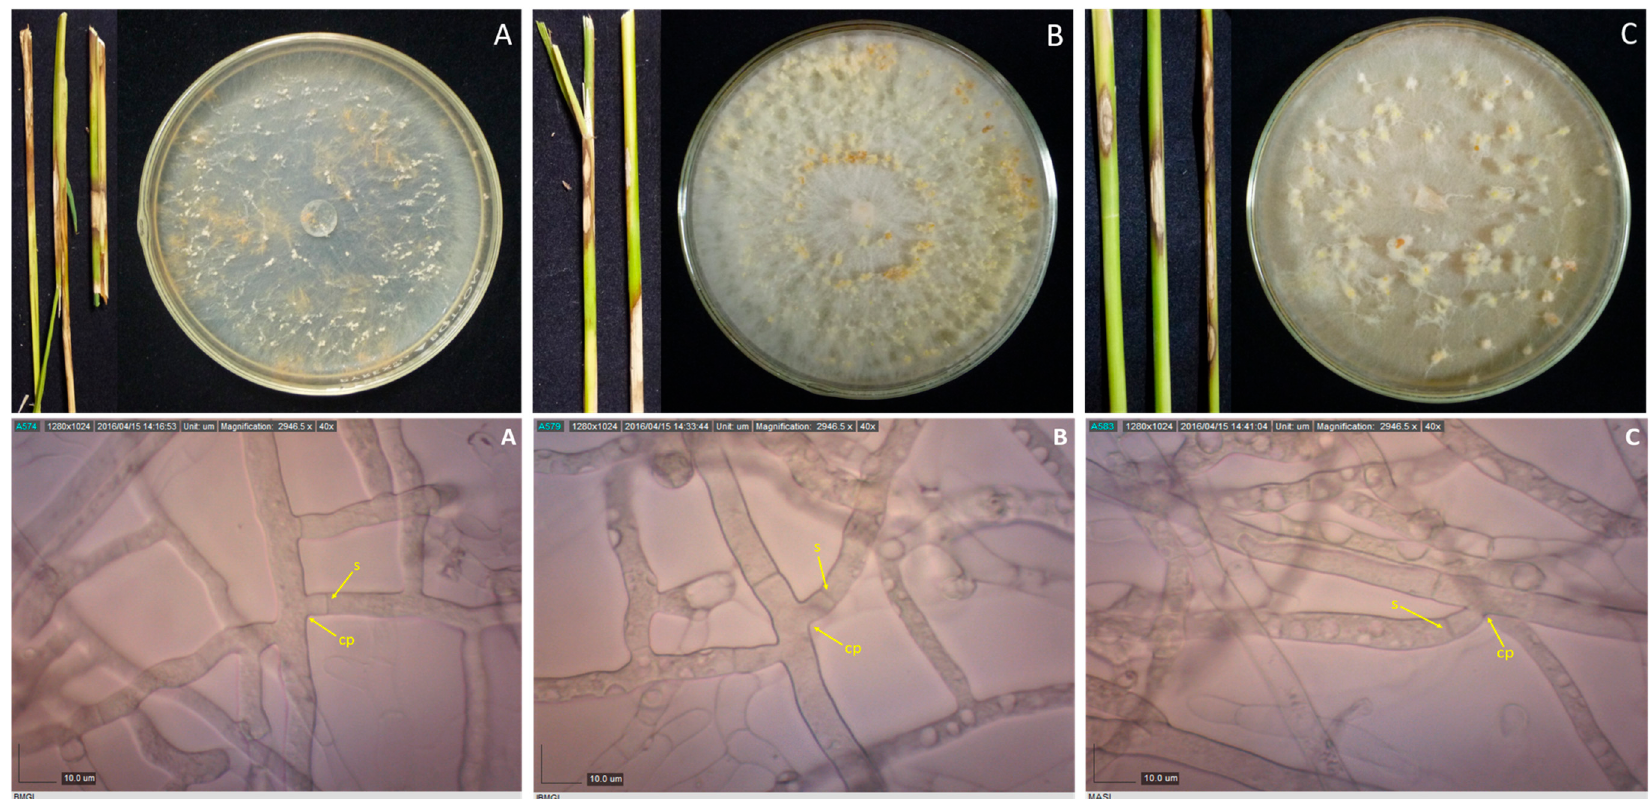
Figure 3. Rice stems showing sheath blight symptoms, and 10-day-old cultures of their corresponding pathogens, as well as their photomicrographs showing the mycelia branching at an acute to right angle with slight constriction at the point (cp) of branching and septum (s) formed near the branching point for isolates BMgL ( A ), IbMgL ( B ), and MaSL ( C ). Samples were viewed at 40×.